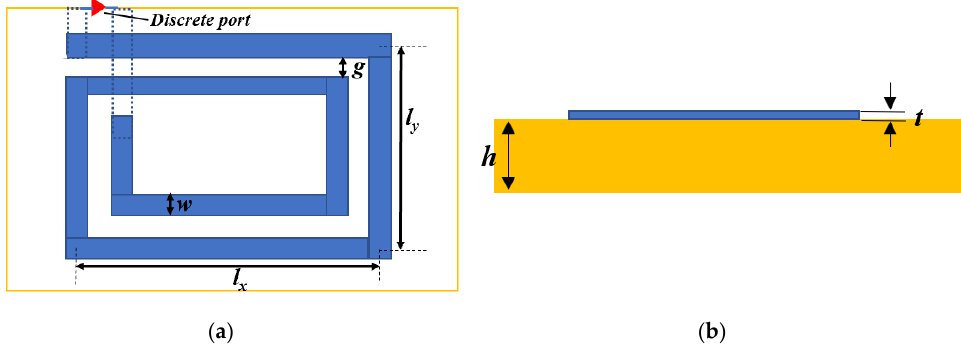
Figure 1. Geometrical parameters of a rectangular PSC on the substrate ( a ) Top view ( b ) Side view.